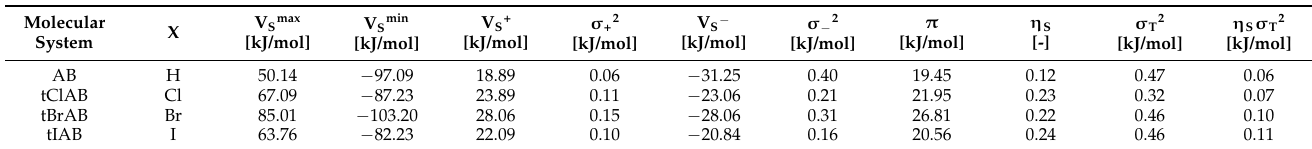
Table 7. Politzer-type statistical analysis of the ESP on the HSs: the minimum and maximum surface potentials (V Smin and V Smax ), average positive and negative surface potentials (V S+ and V S − ), their variances ( σ +2 and σ − 2 ), the total variance ( σ T2 ), the average deviation from the mean surface potential ( π ), balance ( η S ) and indicator of electrostatic interactive tendencies η S σ T2 obtained for the compounds studied.